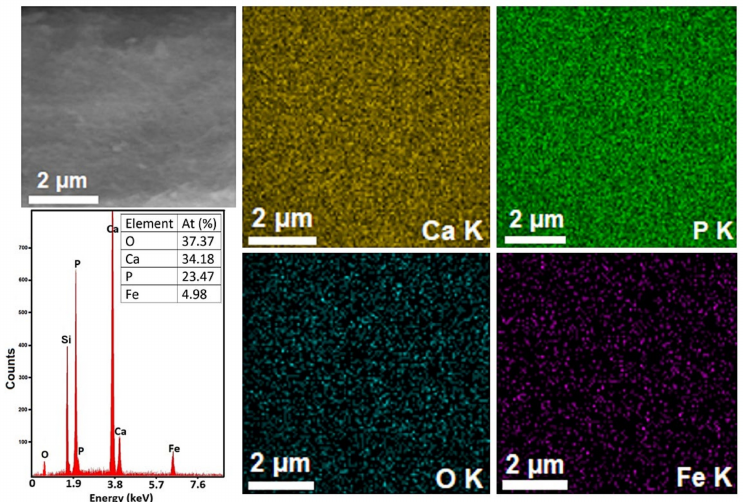
Figure 6. SEM micrographs of elemental distribution, EDS spectra, and elemental distribution maps of HApFe